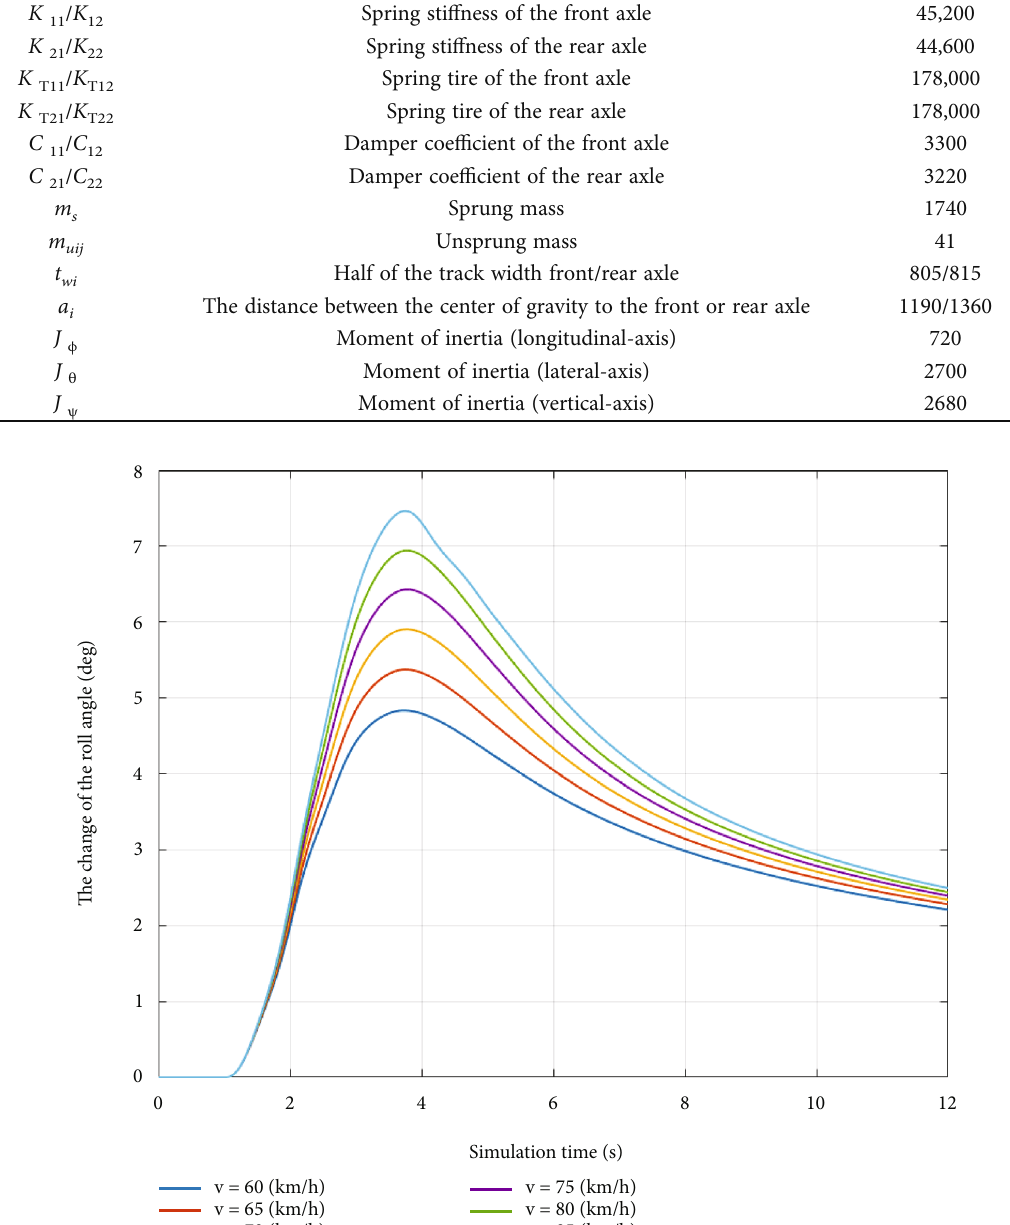
Figure 4: The change of the roll angle (the fi rst case — velocity